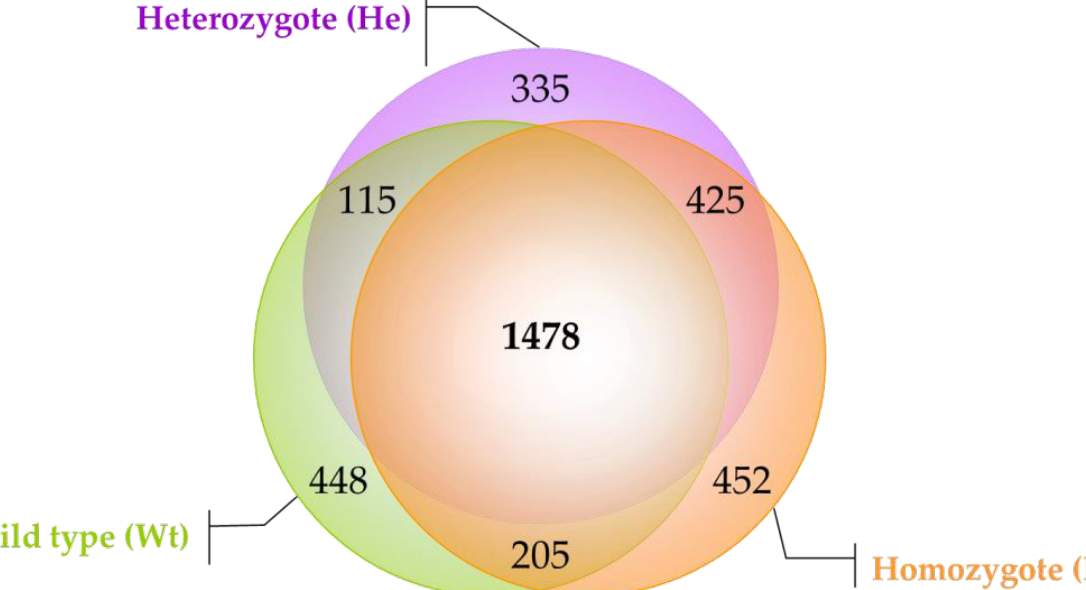
Figure 1. Venn Diagram. The figure shows the distribution of all identified proteins within three investigated categories (Wild type, Wt, green circle; Heterozygote, He, violet circle; Homozygote, Ho, orange circle). About 1400 proteins were shared between the three groups of subjects and approximately 400 proteins were identified as anomalous of each cate- gory.